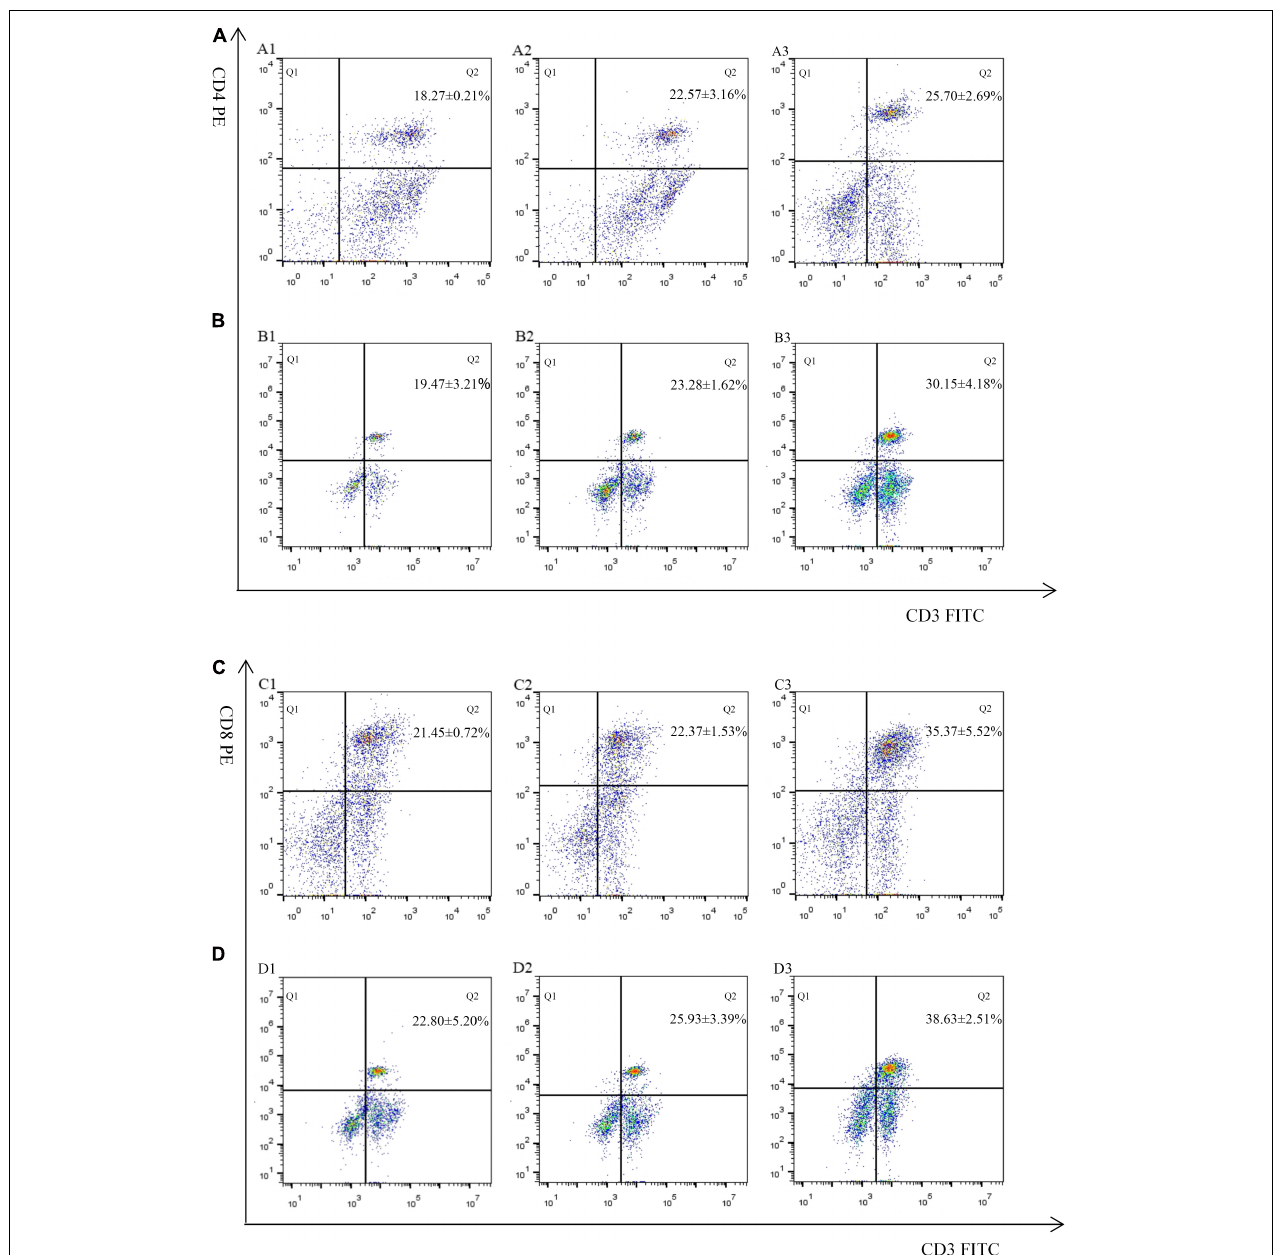
FIGURE 5 | Percentage of T cell subpopulation in the spleen of recombinant protein pET-32a-EmROM3 immunized chickens. N = 5, the data = mean ± standard deviation. (A) Detection of CD4 + /CD3 + T lymphocyte in immunized chicken spleen at 21 days old (7 days after the first immunization). (B) Detection of CD4 + /CD3 + T lymphocyte in immunized chicken spleen at 28 days old (7 days after the booster immunization). (C) Detection of CD8 + /CD3 + T lymphocyte in immunized chicken spleen at 21 days old (7 days after the first immunization). (D) Detection of CD8 + /CD3 + T lymphocyte in immunized chicken spleen at 28 days old (7 days after the booster immunization). 1: PBS (negative control). 2: Detection of T lymphocytes with immunized tag protein pET-32a. 3: Detection of T lymphocytes with immunized recombinant protein pET-32a-EmROM3.